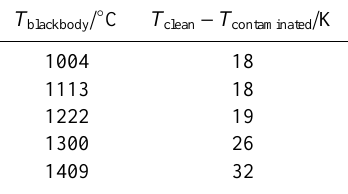
Table 1. Influence of contamination of pyrometer optics for tem- perature measurement with pyrometer MAURER KTR 1075 (man- ufacturer calibration) at PTB Berlin. The contaminated front lens has been used for several years for laser processing in a laterally assembled pyrometer viewing unprotected at the laser–metal inter- action